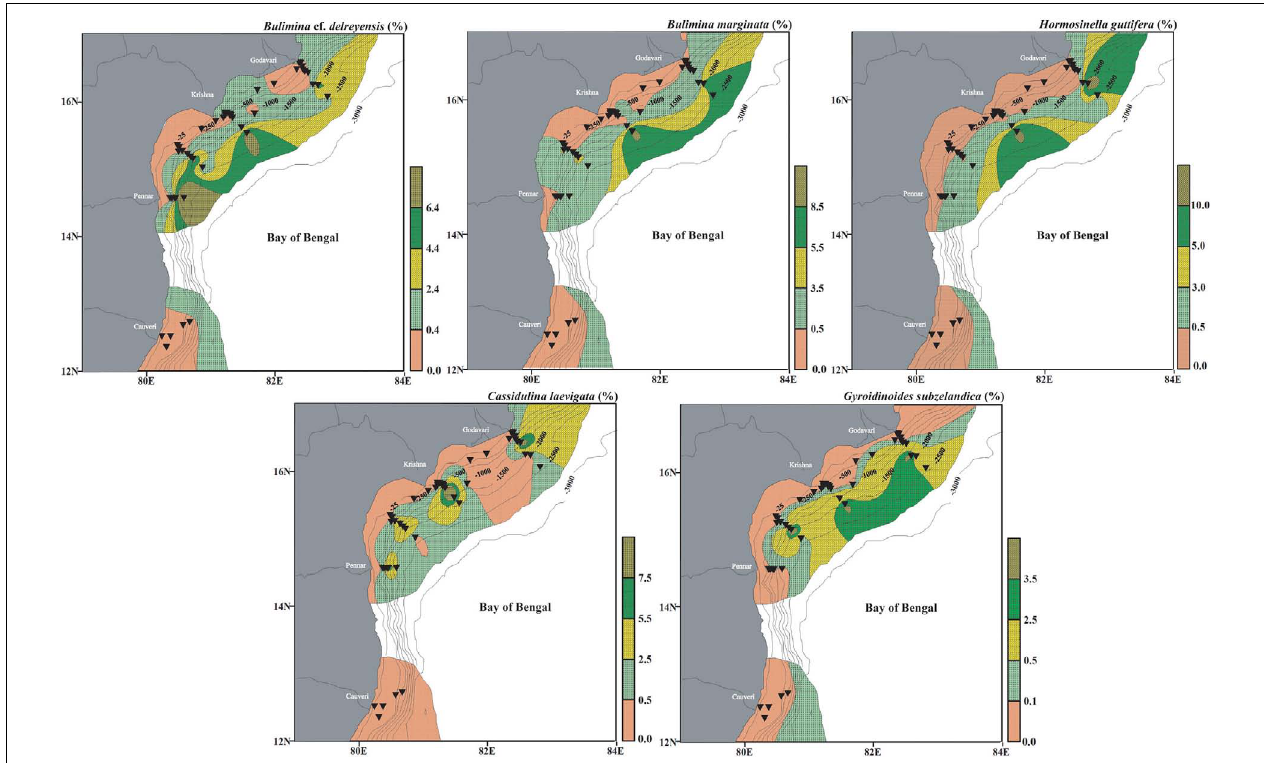
FIGURE 12 | Surface distribution (relative abundance) of dominant living benthic foraminifera representing deep water assemblage (Assemblage III), having a significant negative correlation with CF and C org /TN, in the west-central Bay of Bengal. Bulimina cf. delreyensis, Bulimina marginata , Hormosinella guttifera , Cassidulina laevigata, and Gyroidinoides subzelandica. The stations are marked by black inverted triangles. The thin black lines mark the bathymetric contours.